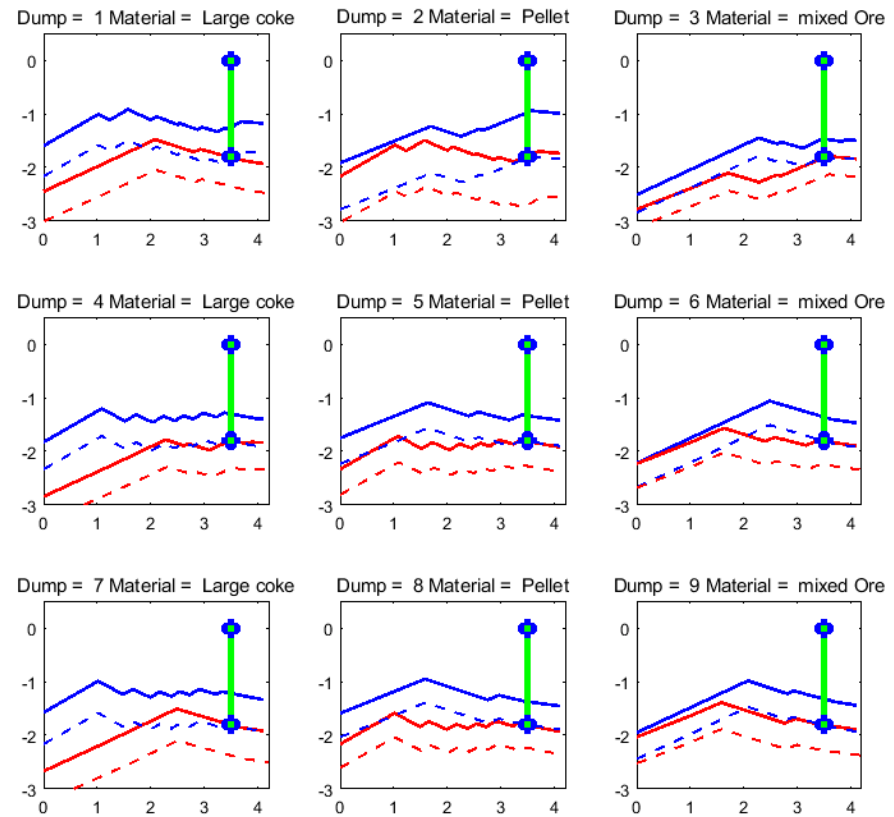
Figure 12. Radial stock profile before (red) and after (blue) each dump simulated by the model. Dashed lines show the corresponding position of the uppermost layer just before the next layer is charged.